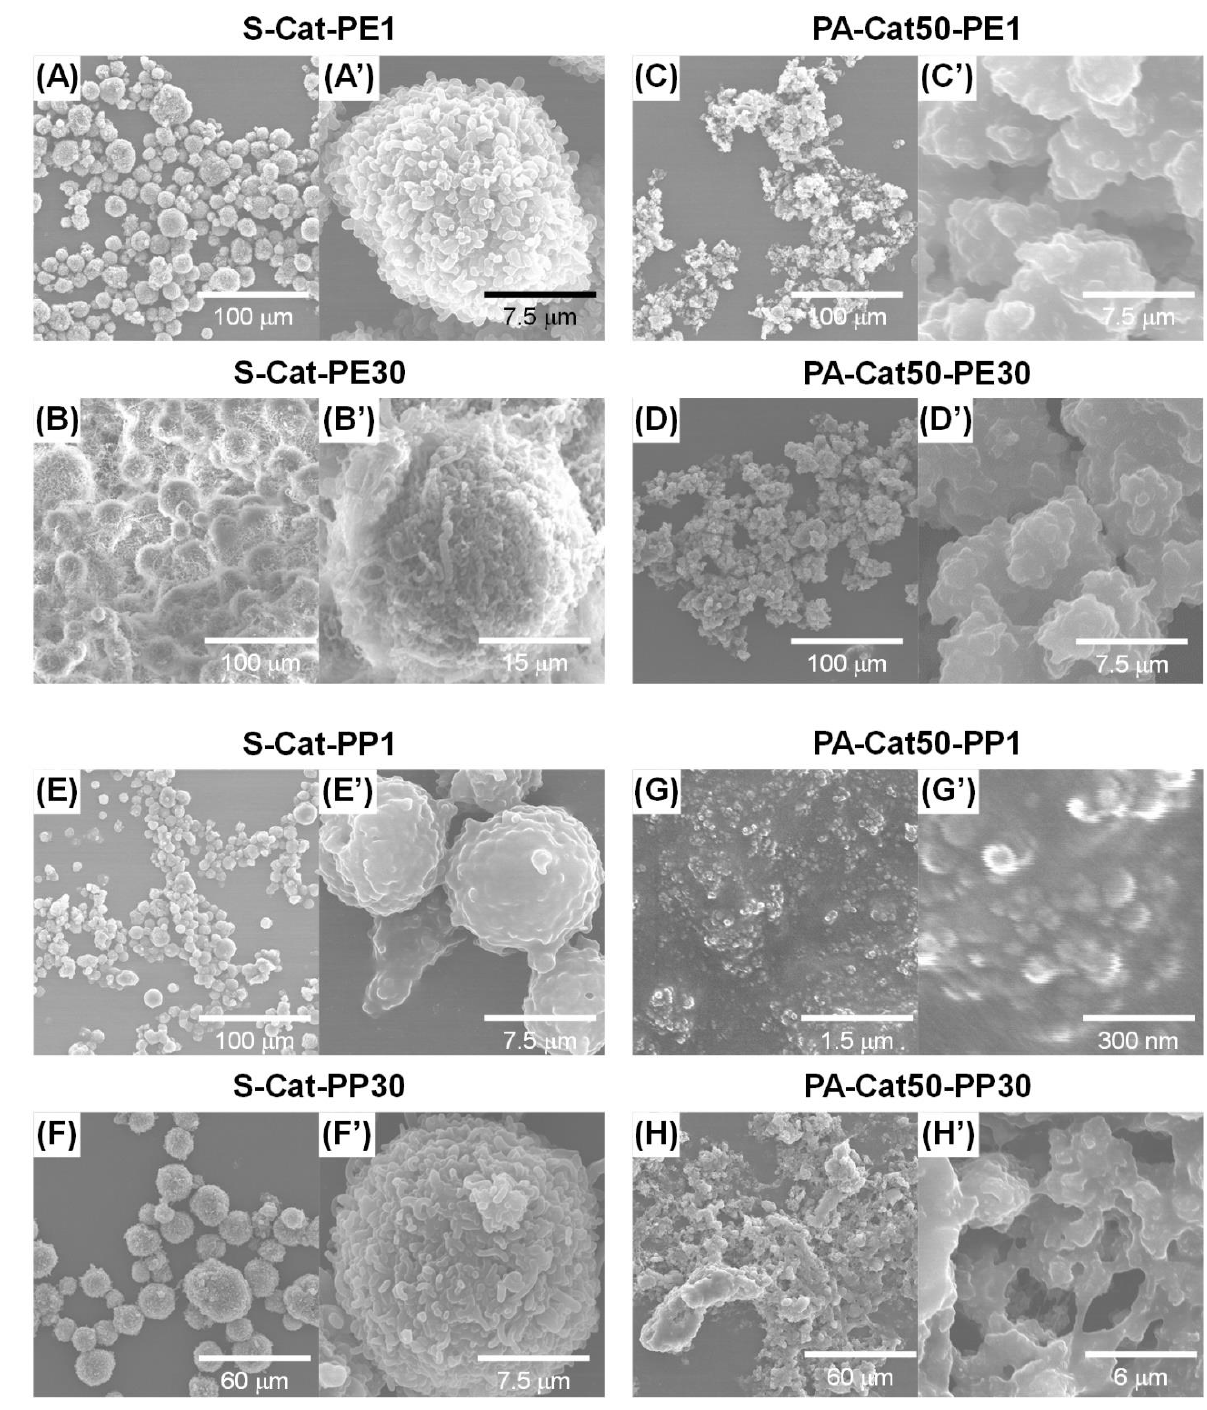
Figure 6. SEM images of polymer particles obtained with S-Cat and PA-Cat50. The sample name corresponds to the catalyst name and polymerization conditions as xx-yyzz (xx: catalyst name, yy: polymer name, zz: polymerization time in min). PE obtained with S-Cat for ( A ) 1 min and ( B ) 30 min. PE obtained with PA-Cat50 for ( C ) 1 min and ( D ) 30 min. PP obtained with S-Cat for ( E ) 1 min and ( F ) 30 min. PE obtained with PA-Cat50 for ( G ) 1 min and ( H ) 30 min. ( A’ – H’ ) high-magnification images of A-H.